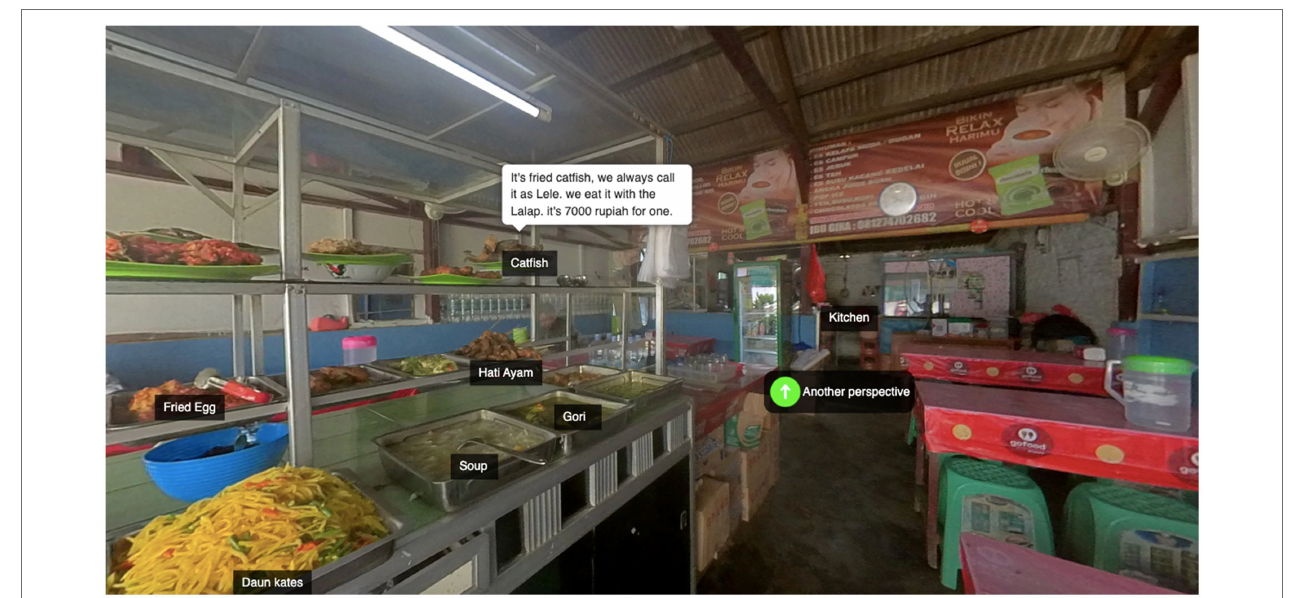
FIGURE 4 | Created content (panoramic tour) of student